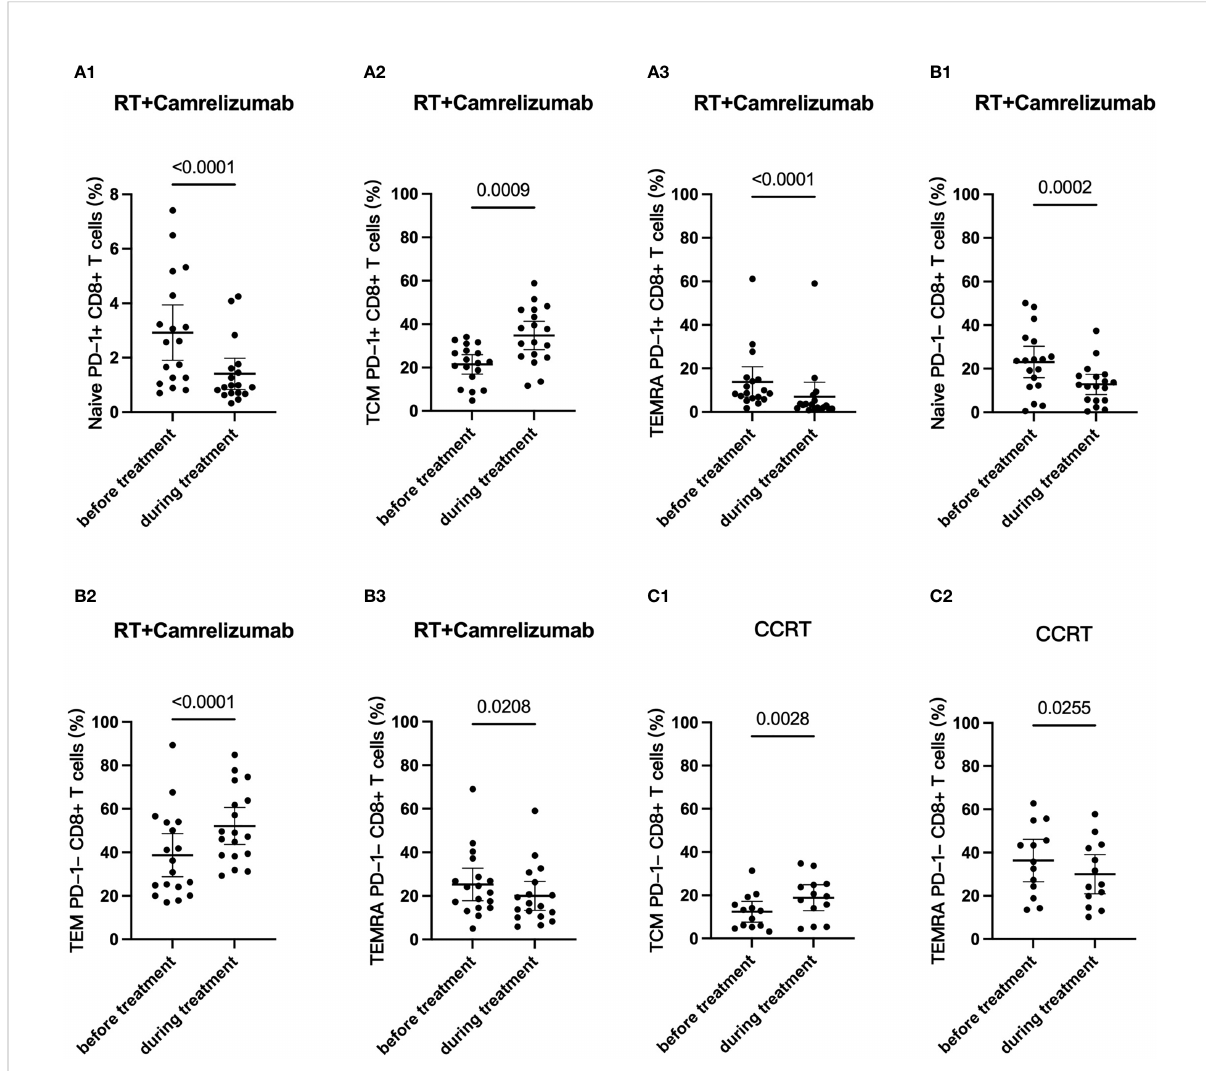
FIGURE 5 Dynamic differentiation status of PD-1 + and PD-1 - CD8 + T-cell subsets. (A) PD-1 + CD8 + T cells in RT plus immunotherapy group. (B) PD1 - CD8 + T cells in RT plus immunotherapy group. (C) PD1 - CD8 + T cells in CCRT